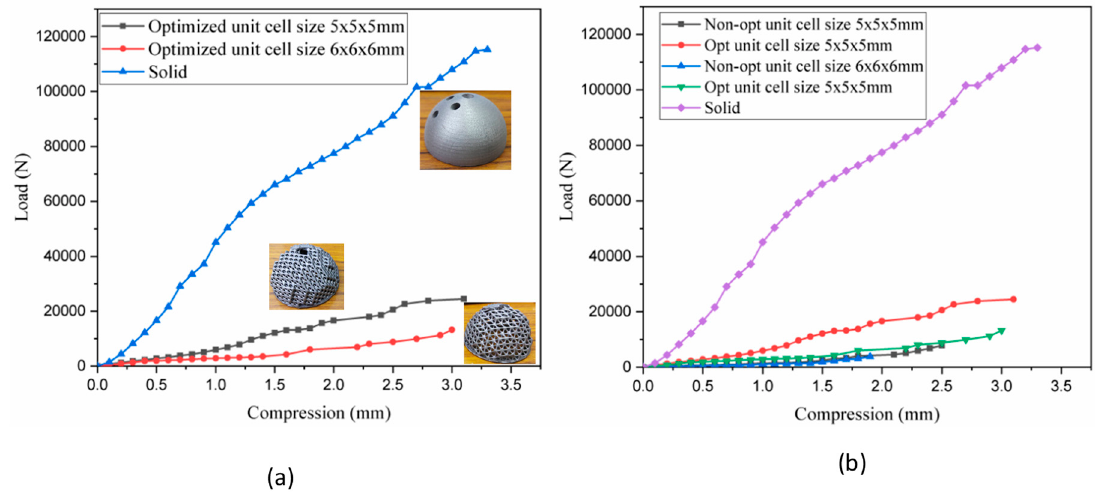
Figure 11. Compressive load-compression curves. ( a ) Solid with optimized, ( b ) all solid, optimized, and optimized.